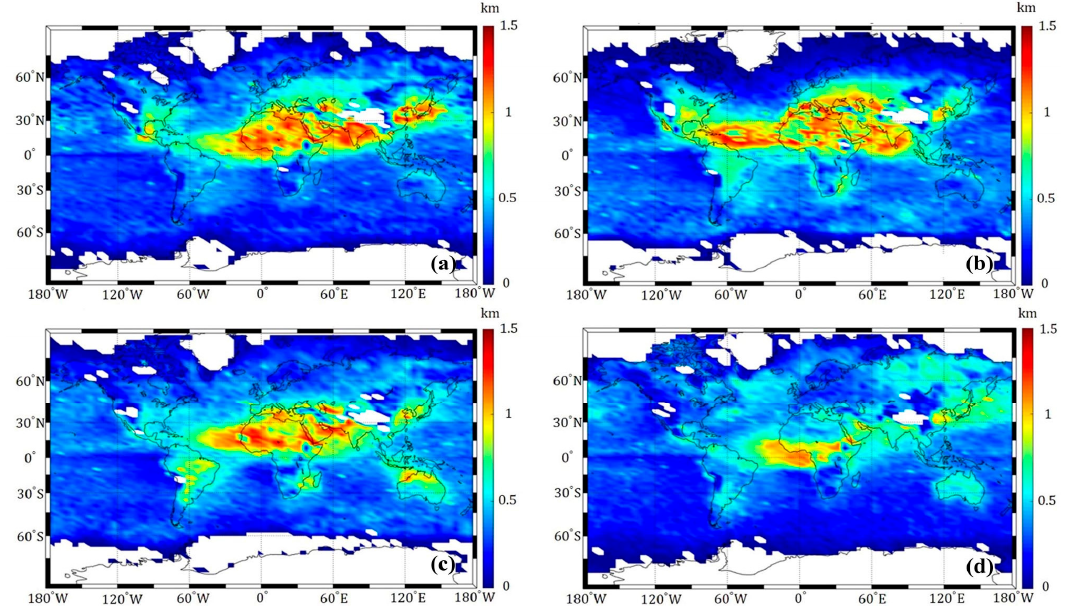
Figure 4. Same as Figure 2 but for the dust aerosol MFASD.